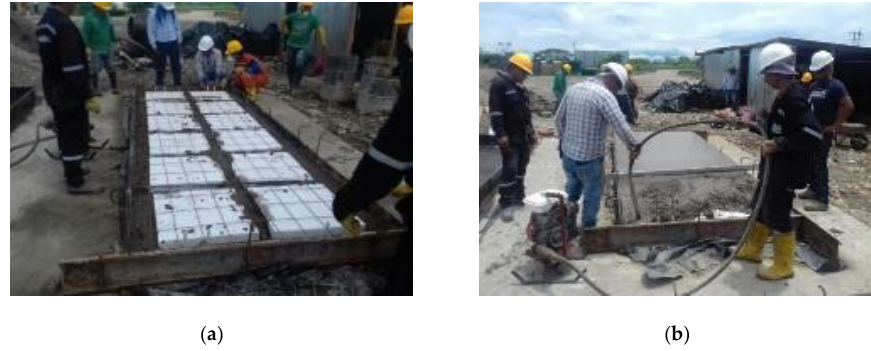
Figure 29. Ariari River, PR68: on-site manufacturing of reinforced concrete vanes, lightened. ( a ) Provision of the lightening material; ( b ) placement of concrete.